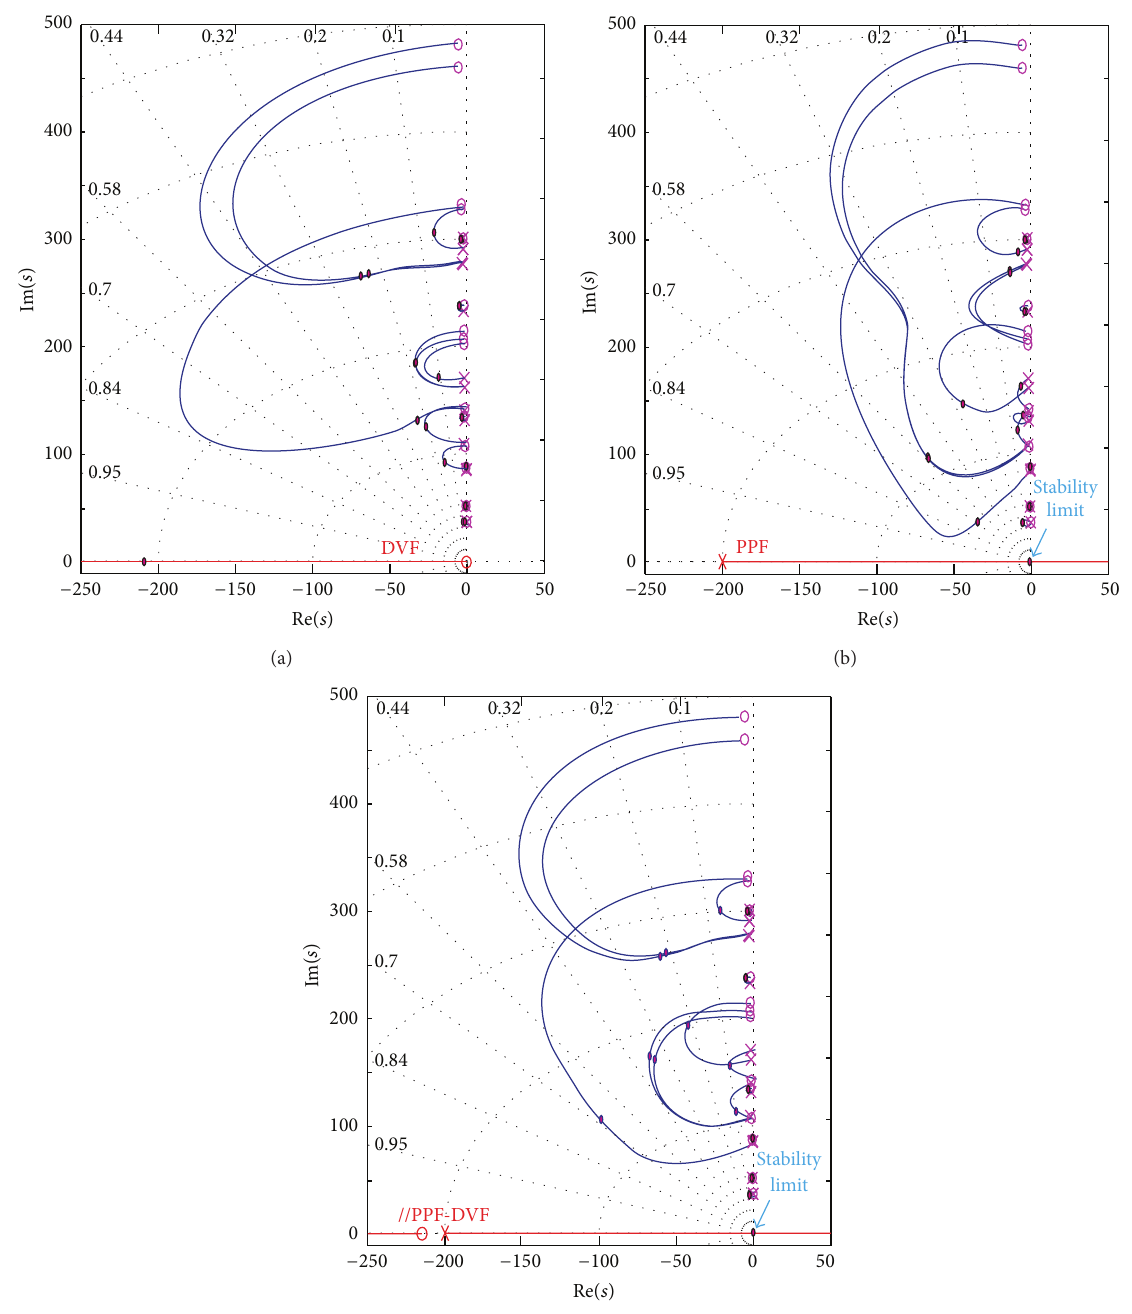
Figure 4: Root locus of the DVF (a), the first order PPF (b), and the parallel PPF-DVF (c) added through four small tendons.